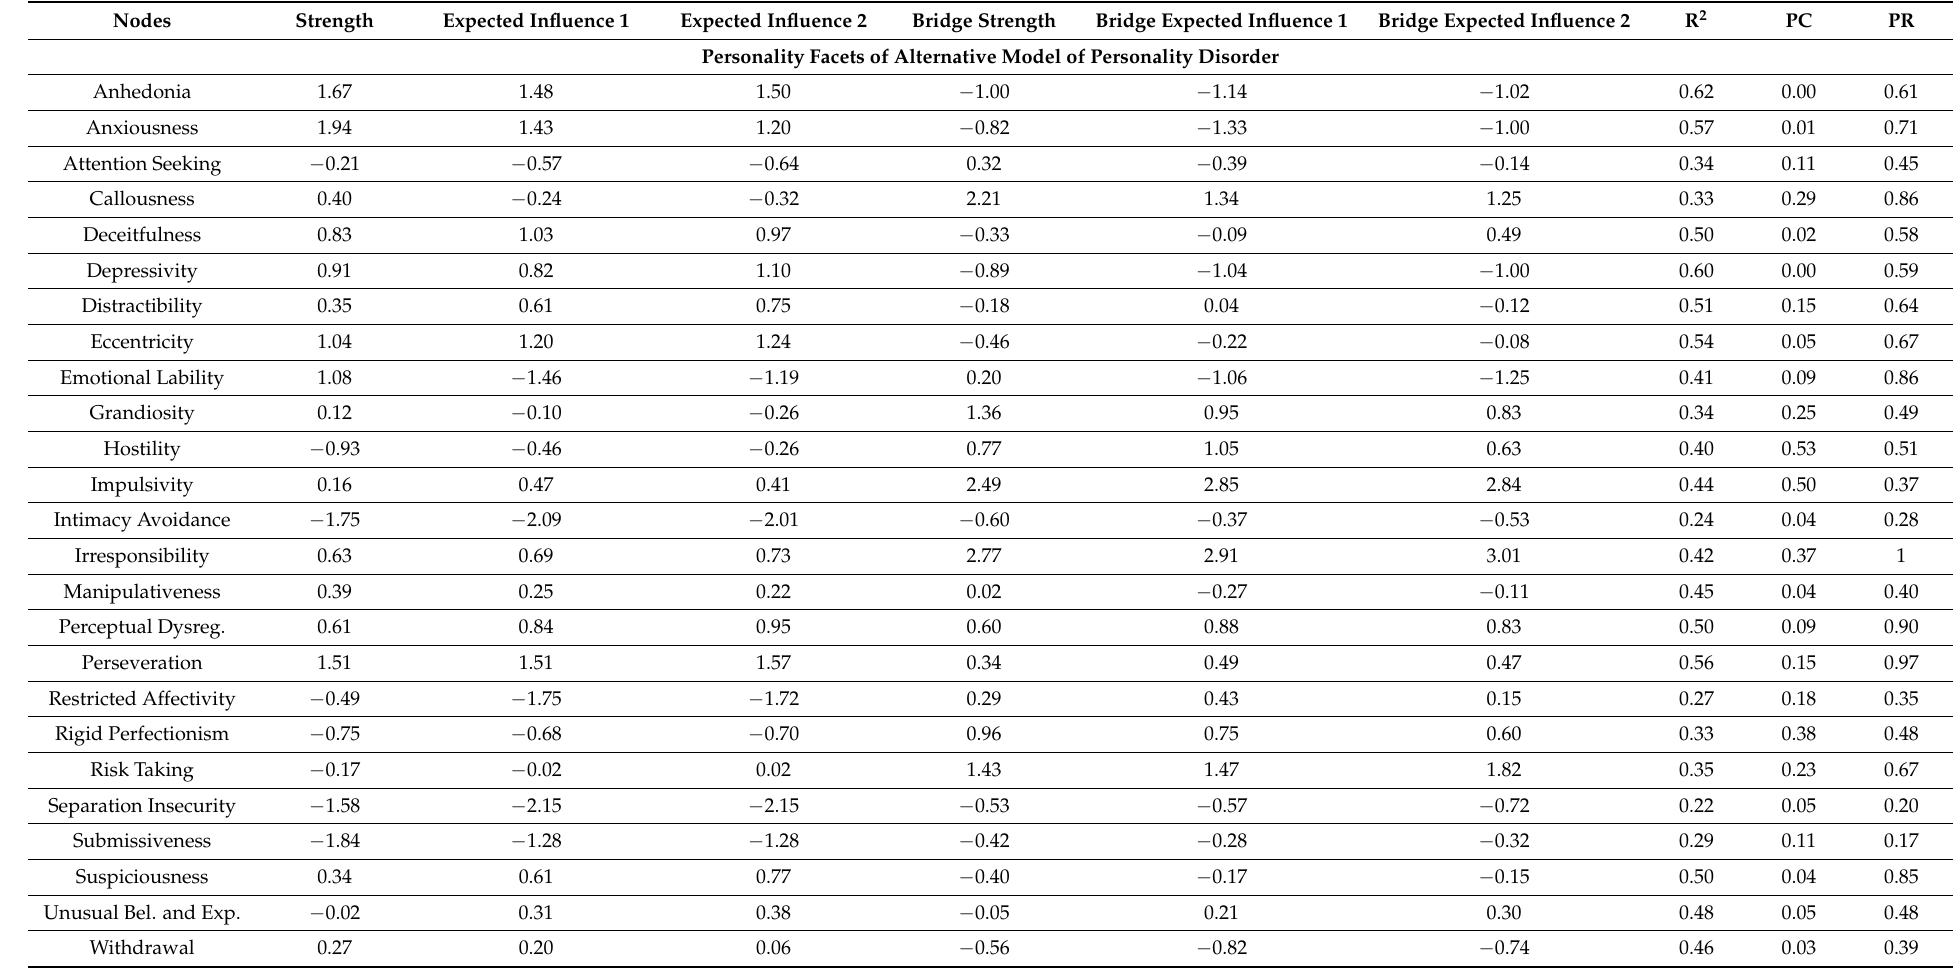
Table 3. Centrality indices and bridge-centrality indices of personality facets and alcohol-use disorder